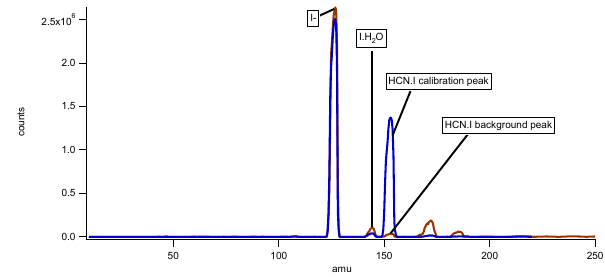
Fig. 2. Mass scan from the CIMS during background (blue line) and encountering a HCN peak at mass 154 (blue